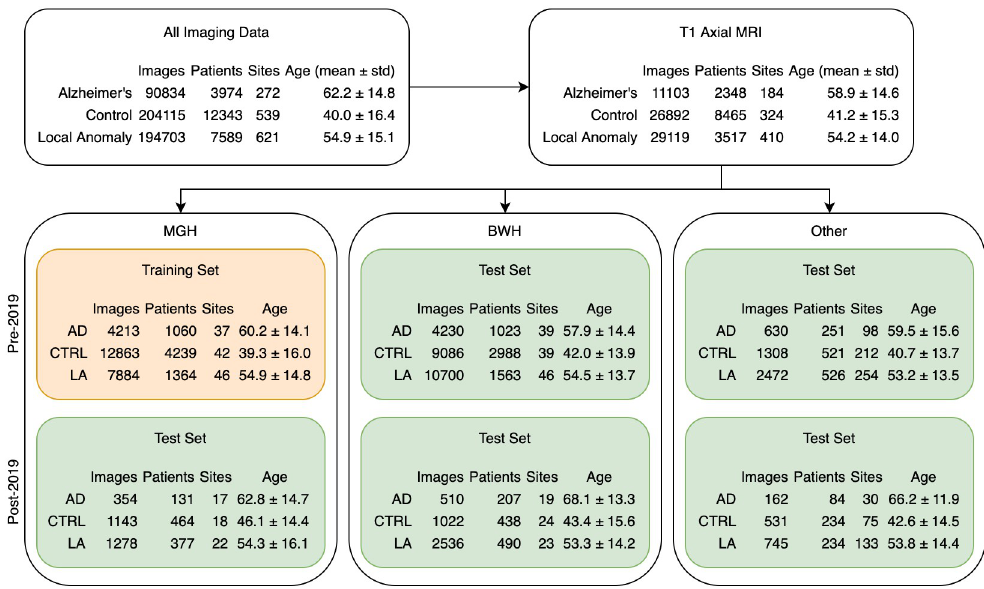
Fig 2. Statistics associated with the three datasets used, pre- and post-2019. T1 Axial MRI, representing the plurality of structural MRI in the Mass General Brigham database, were taken from our full database of imaging data, and, from these, three test sets were isolated. “Local anomaly” refers to patients with lesions, head trauma, or tumors. The average age and standard deviation of each group is shown as